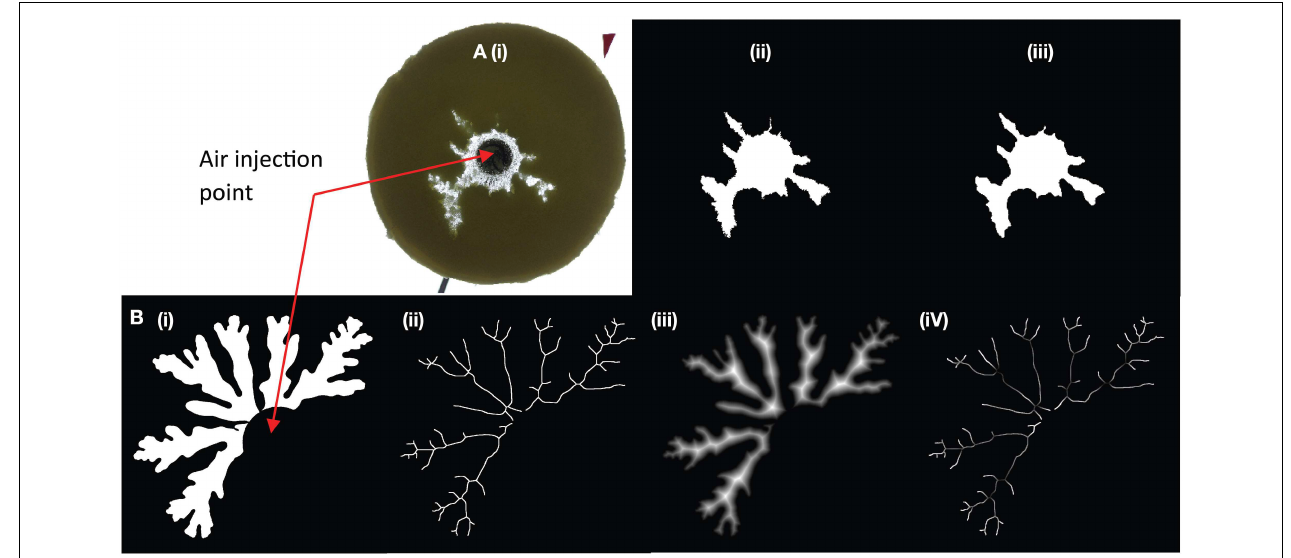
FIGURE 2 | Two examples of finger analysis in (A) a large gap parallel plate experiment, and (B) a small gap Hele-Shaw cell. (A) treatment of a large gap experiment at 63% particles, ∼ 700 Pa s. The original image (i) is thresholded (ii) then smoothed with a median filter (iii). Some details are lost in the fracture-like areas, but the artificial edge roughness is removed. (B) Experiments in small gap Hele-Shaw cells (here 45 vol% particle content, 11 Pa s) needed further processing to determine finger widths. The image is first thresholded as in (A) , then skeletonized (ii) and a distance map is extracted